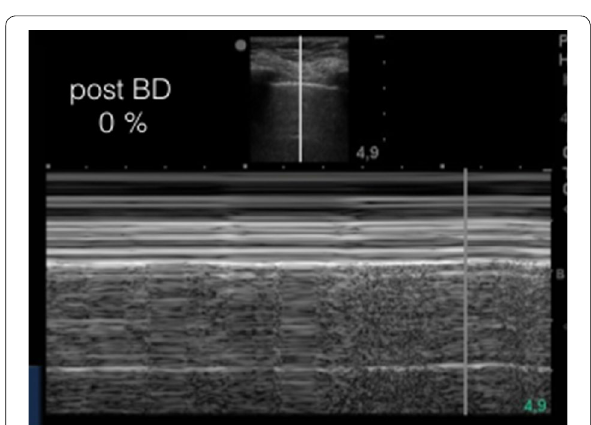
Fig. 3 M-mode re-evaluation of the pleural displacement and index calculation at 21 min of treatment, showing complete resolution of pleural displacement an index